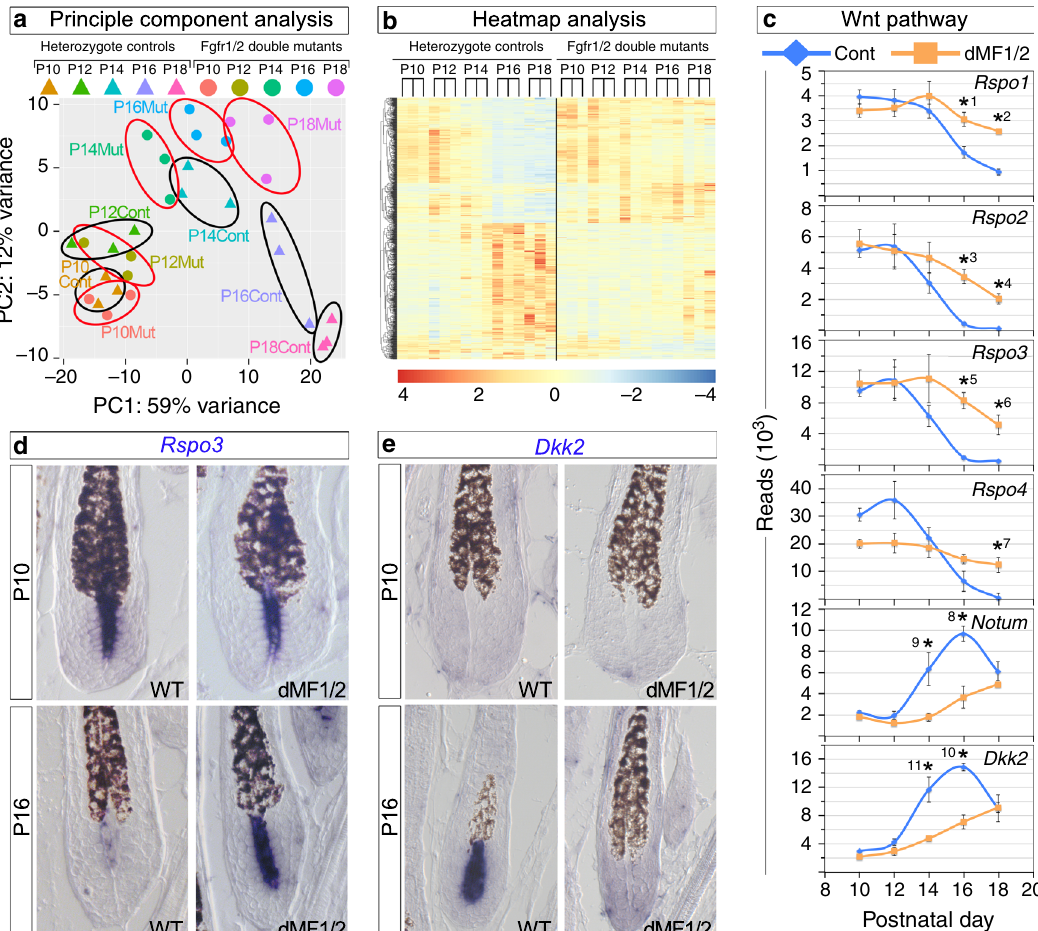
Fig. 3 Abrogation of Fgf signaling in the DP results in altered expression of Wnt agonists and antagonists. a PCA analysis. Each colored triangle or dot represents the DP transcriptome of a single control or mutant mouse, respectively. Black and red circles demarcate control and mutant mice at a given time point, respectively. n = 3 mice per genotype per time point. b Heatmap analysis. Two classes of genes were revealed based on their expression pattern: genes whose expression during anagen gradually accumulate in control mice while remains low in the mutant and genes whose expression is progressively reduced in the control while persists at higher levels in mutant mice. c Graphic representation of the sequence reads of the RNA-seq analysis for Wnt agonists ( Rspo1 – 4 ) and antagonists ( Notum and Dkk2 ). Note the different scales of the reads. Data are mean ± SEM. Two-sided modi fi ed t -test adjusted for multiple comparisons using the Benjamin – Hochberg correction was employed. *1 Padj = 0.001, *2 Padj = 7.14E − 11, *3 Padj = 3.26E − 08, *4 Padj = 3.18E − 57, *5 Padj = 3.48E − 24, *6 Padj = 4.91E − 26, *7 Padj = 4.05E − 38, *8 Padj = 0.0003, *9 Padj = 0.02, *10 Padj = 3.2E − 06, *11 Padj = 4.14E − 07. n = 3 mice per genotype per time point. d , e In situ hybridization of Rspo3 and Dkk2 at P10 and P16 is shown to illustrate the speci fi c and dynamic expression of these genes in the DP and their altered expression in the mutant. RNA transcripts are in dark blue and pigmented hair shafts in black. n > 5 mice per genotype per time point. Scale bar, 25 μ